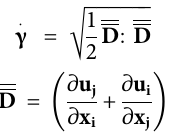
Frontiers in Bioengineering and Biotechnology |